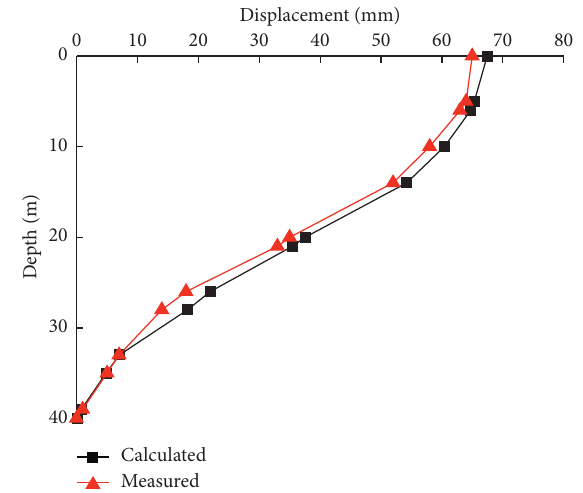
Figure 11: Comparison of the vertical layered displacements at and below the central